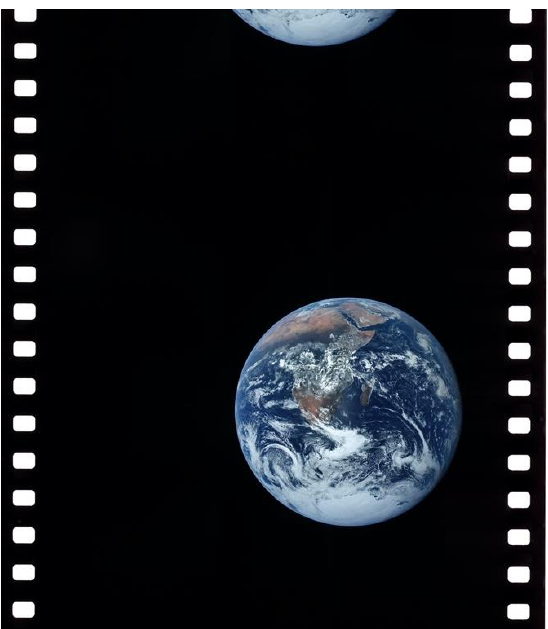
Figure 1. Scanned film of NASA AS17-148-22727 of the whole Earth disk acquired by the Crew of Apollo 17 on 7 December 1972.